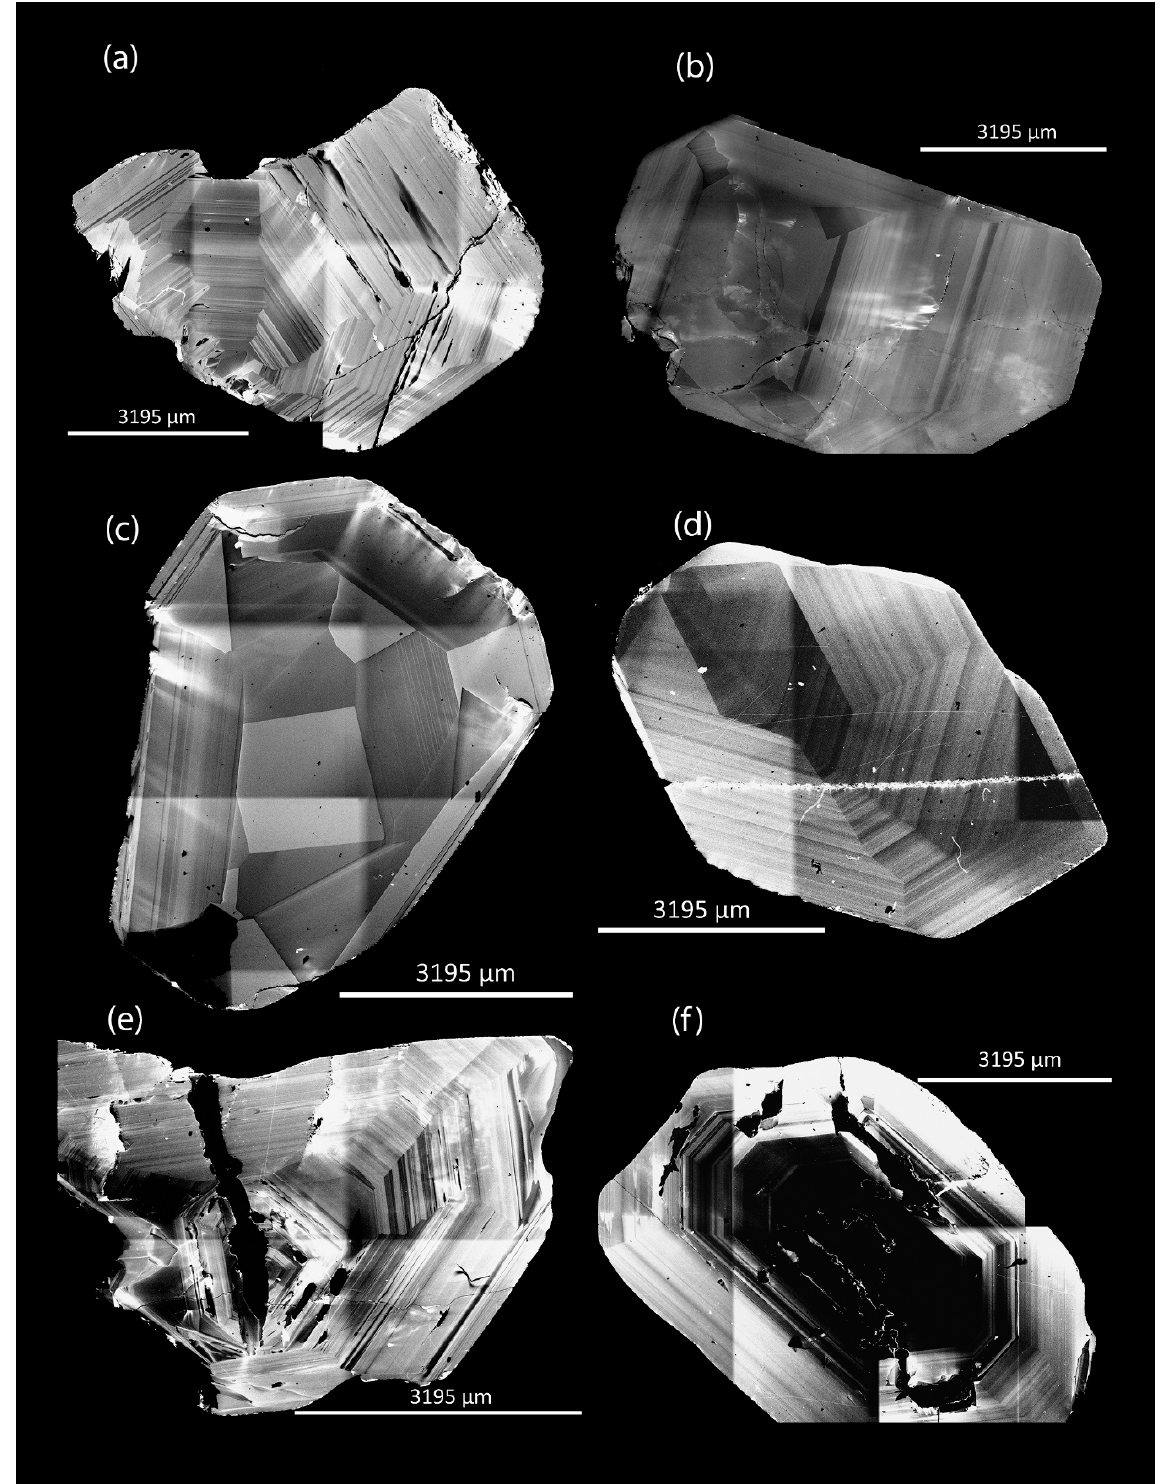
Figure 7. Cathodoluminescence images of RVP zircon xenocrysts showing both oscillatory and sector zonation. Darker zones are enriched in Th, U, and REE: ( a ) concentric zoning in BC43-2, ( b ) concentric zoning in PT49-2, ( c ) sector zoning in PT48-3, ( d ) sector and concentric zoning in BL54-3, ( e ) sector and concentric zoning in BL53-2, and ( f ) dark, CL-inactive core in BL53-1.